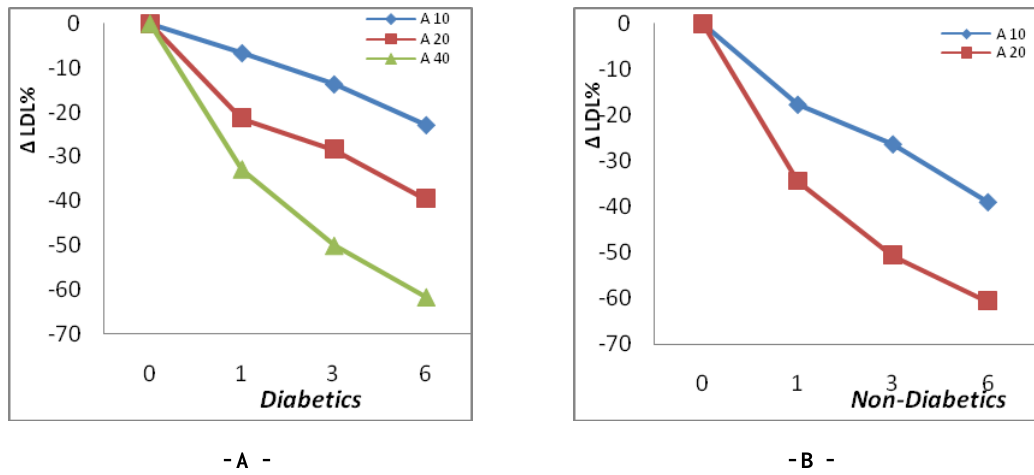
Figure 2 :Line chart showing percentage of serum ldl-cholesterol changes after treatment with atorvastatin in diabetics(A) & non-diabetics(B)